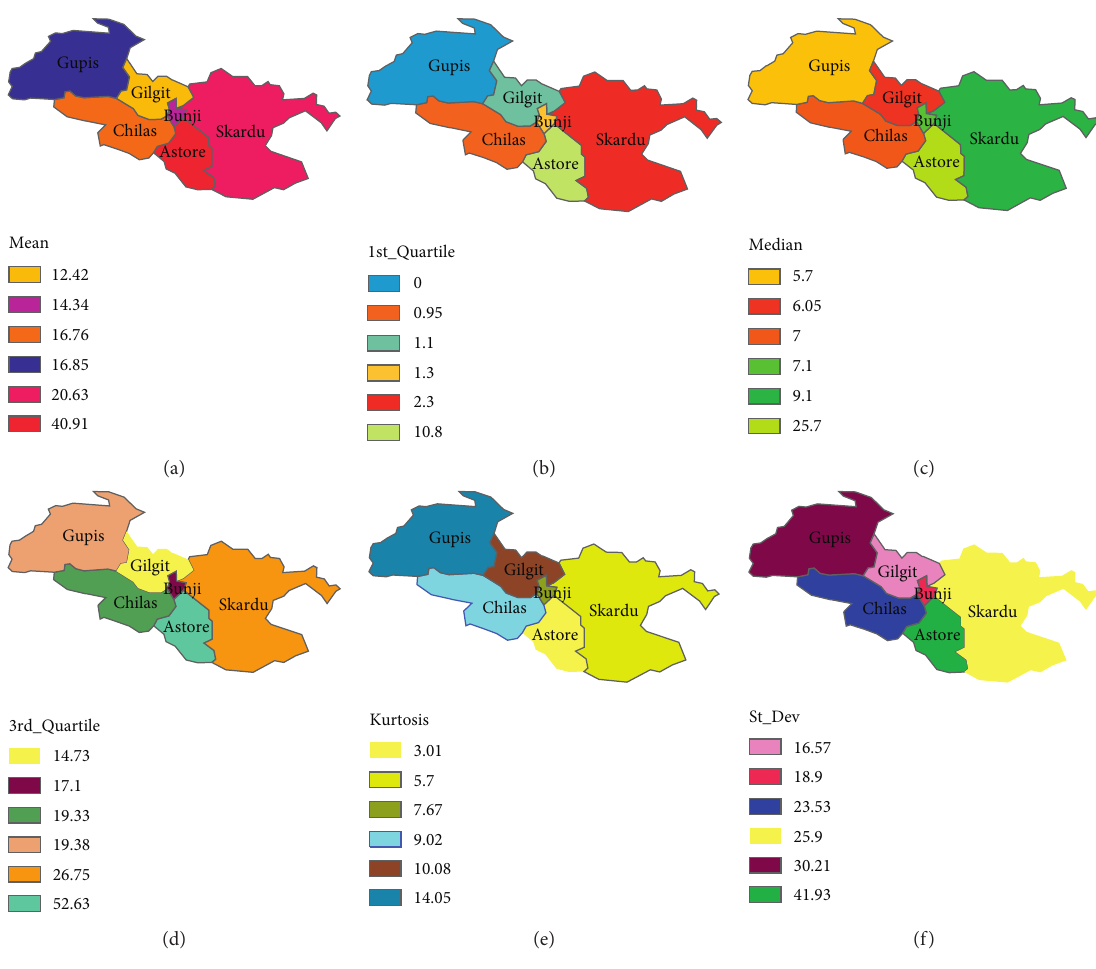
Figure 2: The climatological characteristics of the precipitation to describe the period from January 1971 to December 2017 of specified stations. The (a) mean, (b) 1st-quartile, (c) median, (d) 3 rd _quartile, (e) kurtosis, and (f)